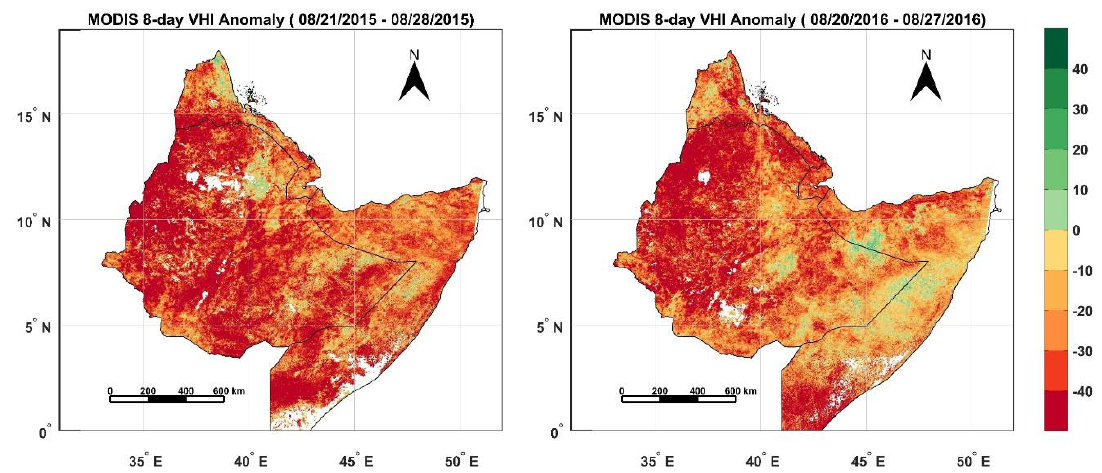
Figure 6. MODIS Vegetation Health Index (VHI) anomaly map from August 2015 (left) and August 2016 (right), illustrating extreme drought conditions in the HOA. In most of the HOA region, VHI anomaly values were negative in August 2015 and August 2016, which indicated that VHI values were significantly lower than in normal years.